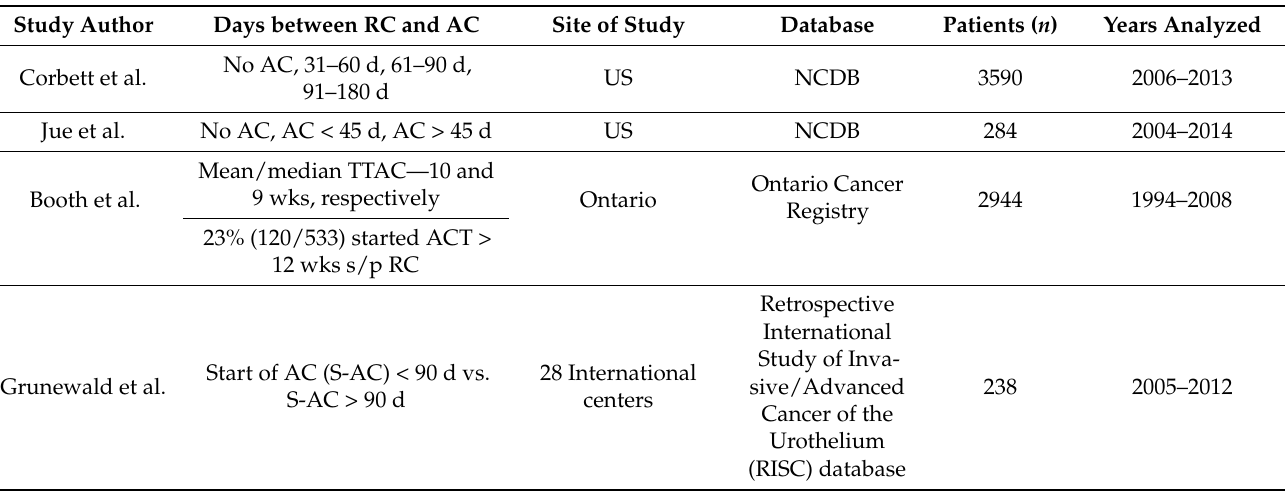
Table 2. Summary of